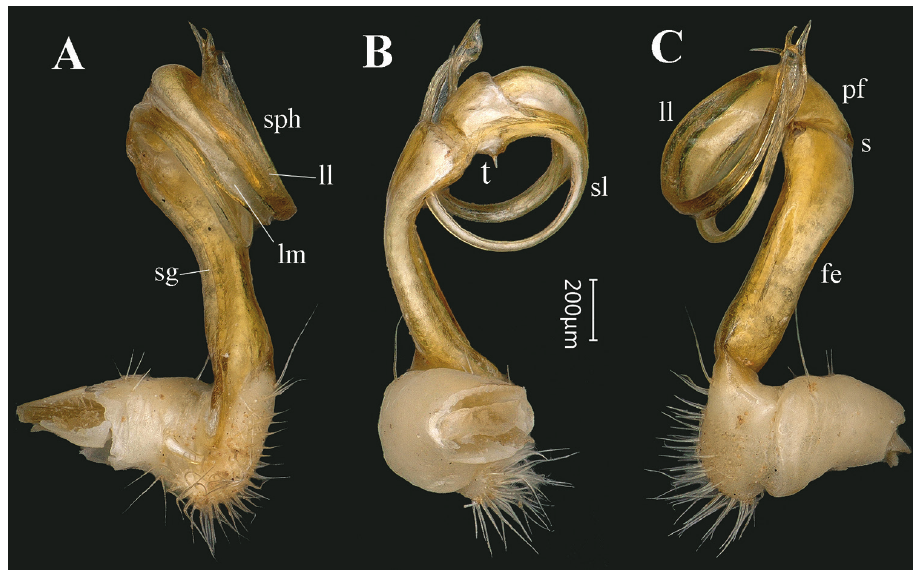
Figure 7. Tonkinosoma tiani sp. n., ♂ paratype from Ganhan Cave. A–C left gonopod, mesal, anterior and lateral views, respectively. Abbreviations: fe = femorite; ll = lamella lateralis; lm = lamella medialis; pf = postfemur; s = sulcus; sg = seminal groove; sl = solenomere; sph = solenophore; t = tooth.